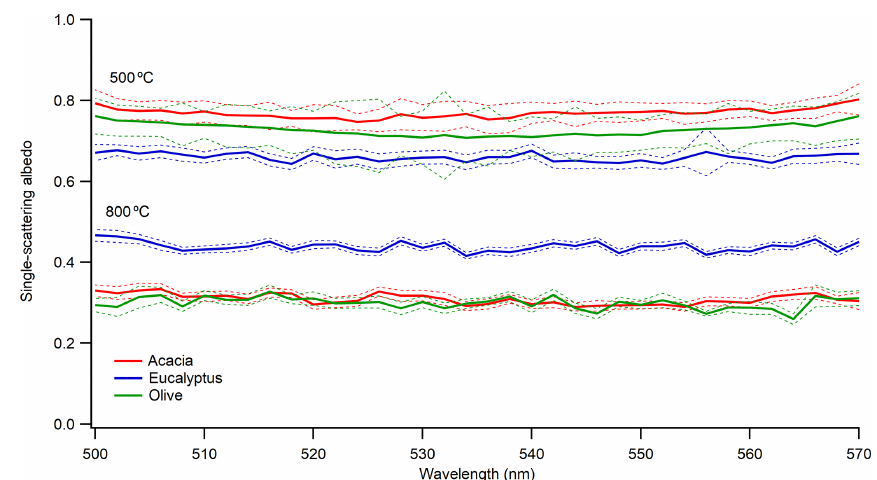
Figure 4. Single-scattering albedo of 300nm size-selected aerosol emitted at combustion temperatures of 500 and 800 ◦ C. Solid blue, green, and red lines are for the average SSA from the three measurements, and the dotted lines are the corresponding uncertainties (1SD – standard deviation) in the measured